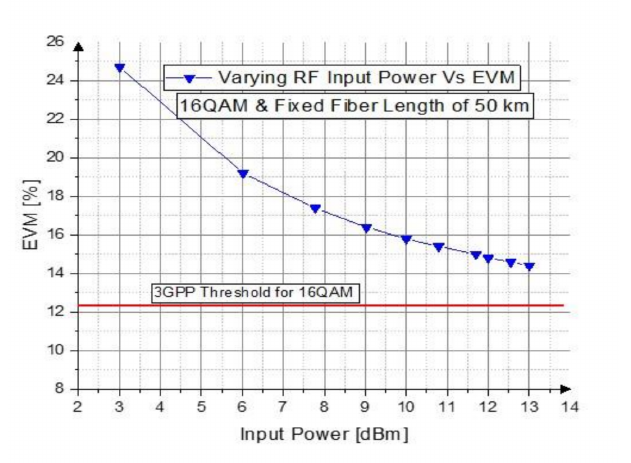
Figure 20. EVM results obtained for varying RF input power levels for a fixed fiber length of 50 km using 16QAM as the modulation